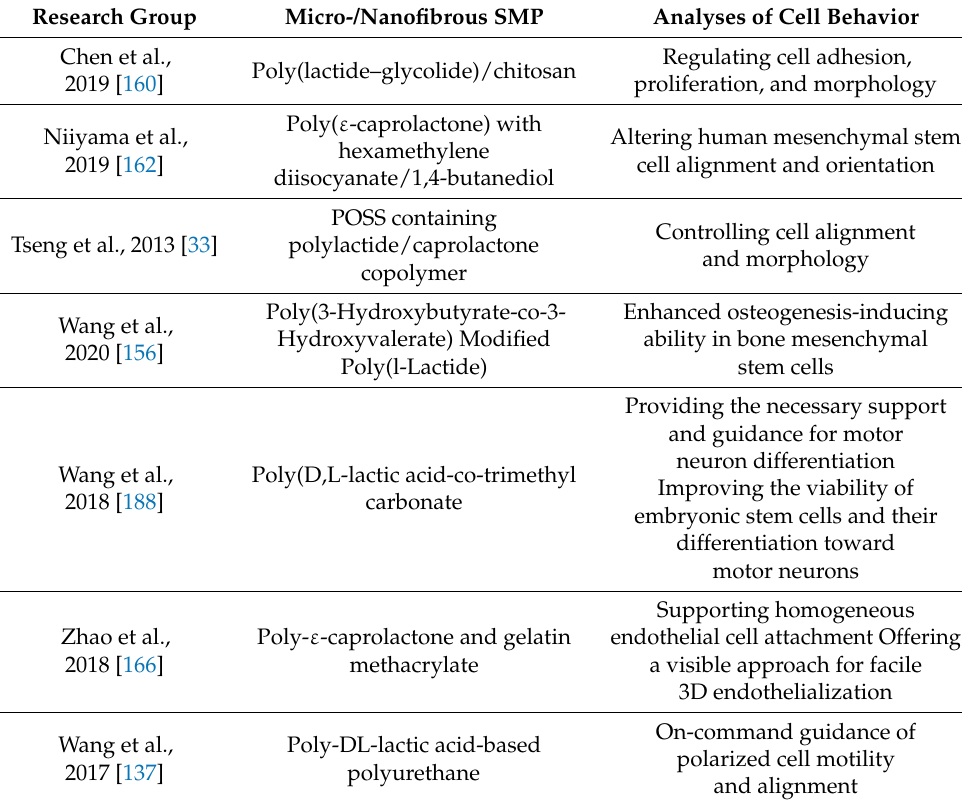
Table 2. A summary of recent studies on the regulation of cell behaviors using biomimetic SMP